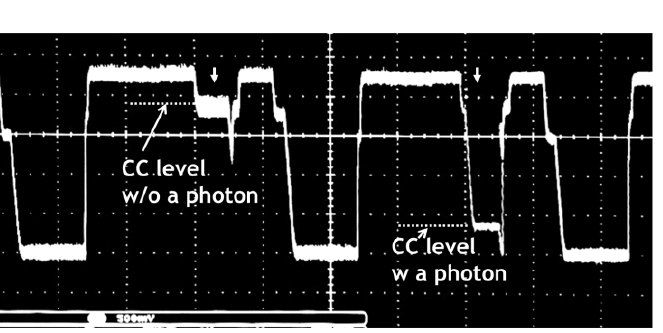
Figure 10. Multiplication factor of VAPD as a function of applied substrate voltage, V sub . It is noted that V sub is actually negative since the substrate is p-type and the bias is reversed.